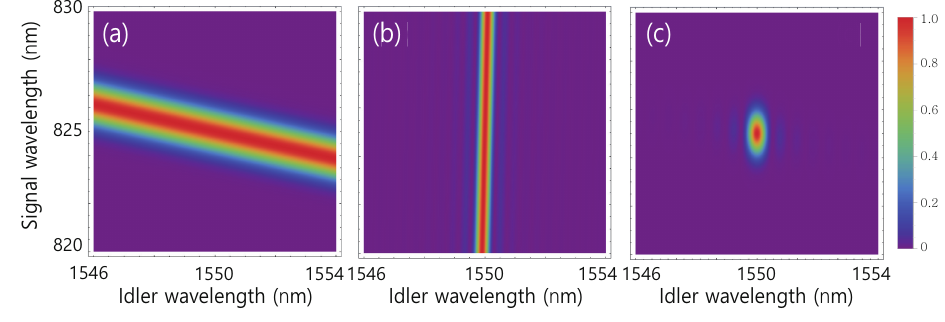
Figure 17. ( a ) Pump envelope function, | α ( ν s , ν i ) | 2 , governed by energy conservation. ( b ) Phase-matching function, | Φ ( ν s , ν i ) | 2 , governed by momentum conservation. ( c ) Joint spectral amplitude, | F ( ν s , ν i ) | 2 , as expressed in Equation